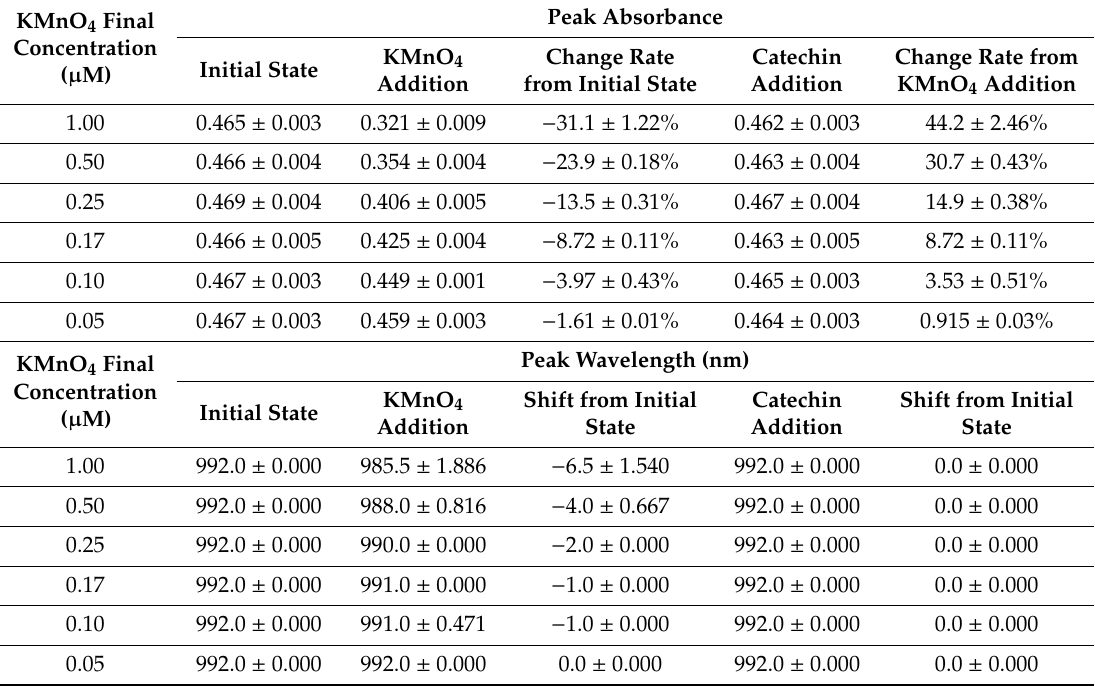
Table 1. Effects of KMnO 4 concentration on the absorption spectra and shift in the peak position. These data are presented as the average of three independent experiments. The final catechin concentration was 6.2 mM. There was a correlation between KMnO 4 concentration and the extent of the redox reaction.